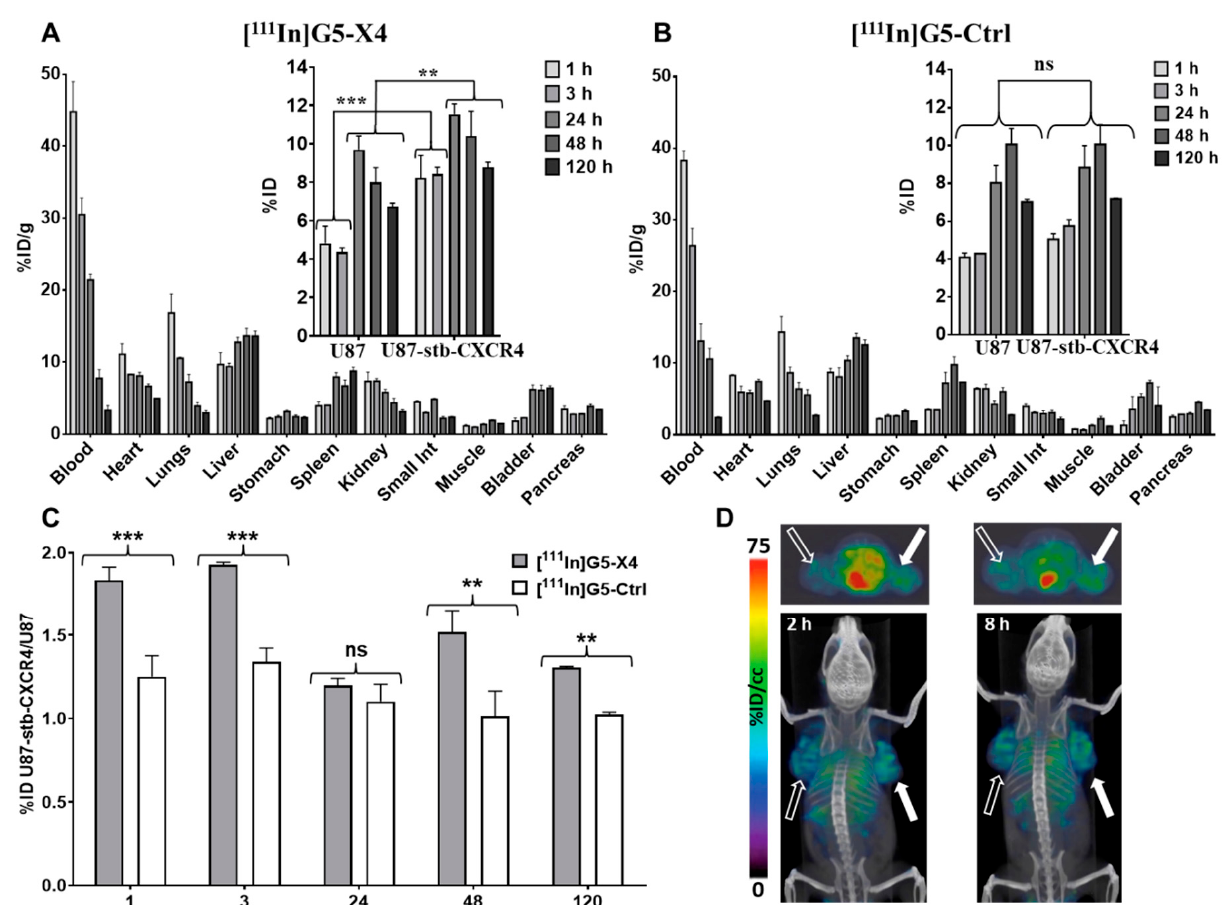
Figure 3. Evaluation of [ 111 In]G5-X4 CXCR4 specificity. ( A , B ) Ex vivo biodistribution of [ 111 In]G5-X4 and [ 111 In]G5-Ctrl in NOD/SCID mice bearing U87 and U87-stb-CXCR4 tumors at 1 h, 3 h, 24 h, 48 h, and 120 h after injection (presented as percent of injected dose per gram tissue %ID/g, n = 3 or 4, *** p < 0.01, ** p < 0.05, ns—non-significant). ( C ) U87-stb-CXCR4/U87 ratios demonstrating faster uptake and enhanced retention of [ 111 In]G5-X4 in U87-stb-CXCR4 tumors vs. U87 tumors and [ 111 In]G5-Ctrl both tumors. ( D ) Transaxial and volume-rendered SPECT/CT images of mouse bearing U87-stb-CXCR4 (solid arrow) and U87 (hollow arrow) tumors collected 2 and 8 h after injection of [ 111 In]G5X4. Imaging results are consistent with ex vivo biodistribution data indicating higher uptake of [ 111 In]G5-X4 in U87-stb-CXCR4 tumor compared to U87 tumor with relatively high background at early time